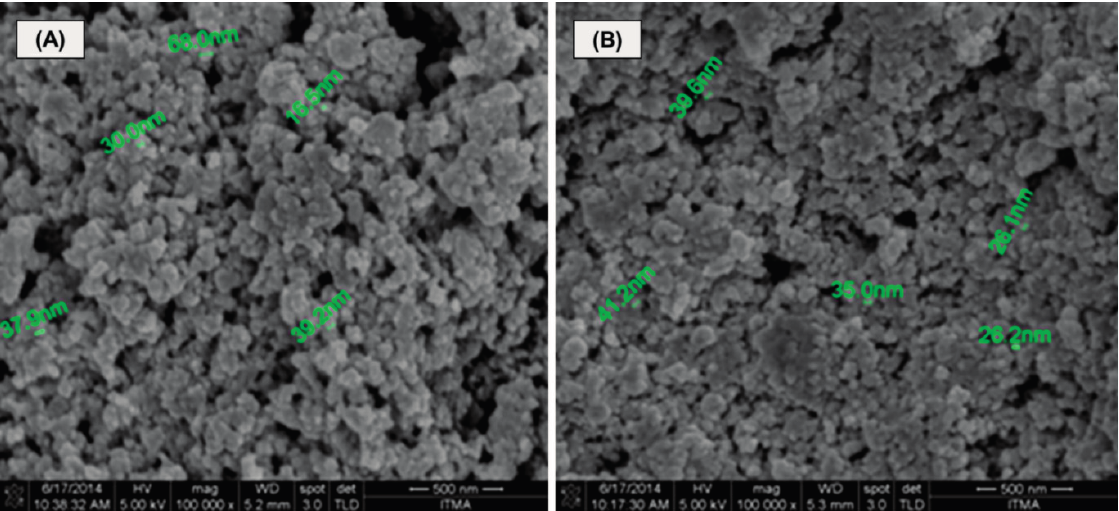
Figure 2. FE-SEM images of the Hg(II)-imprinted polymer (MIP) ( A ) and the non-imprinted polymer (NIP) ( B ) (magnification: 100,000×). Scale bar = 500 nm.